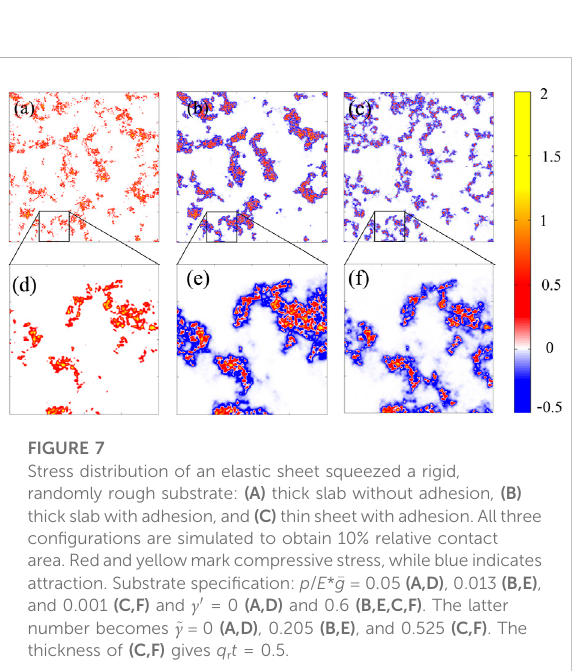
Stress distribution of an elastic sheet squeezed a rigid, randomly rough substrate: (A) thick slab without adhesion, (B) thickslabwith adhesion,and (C) thinsheet withadhesion.All three con fi gurations are simulated to obtain 10% relative contact area.Redandyellowmarkcompressivestress,whileblueindicates attraction. Substrate speci fi cation: p / E * (cid:2) g (cid:1) 0 . 05 (A,D) , 0.013 (B,E) , and 0.001 (C,F) and γ ′ = 0 (A,D) and 0.6 (B,E,C,F) . The latter number becomes ~ γ (cid:1) 0 (A,D) , 0.205 (B,E) , and 0.525 (C,F) . The thickness of (C,F) gives q r t = 0.5.